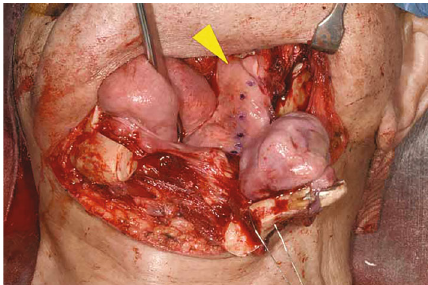
Figure 4: Intraoperative photomicrograph showing surgical safety margin of about 10mm set in the normal-looking tissue